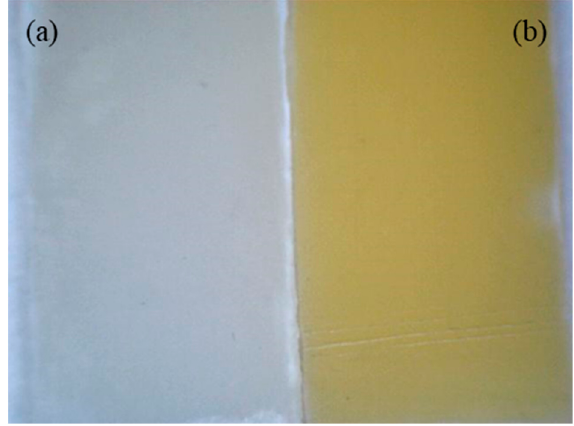
Figure 9. Picture of PLA/P(3.4 HB) with flavone sample before ( a ) and after ( b ) solar aging.